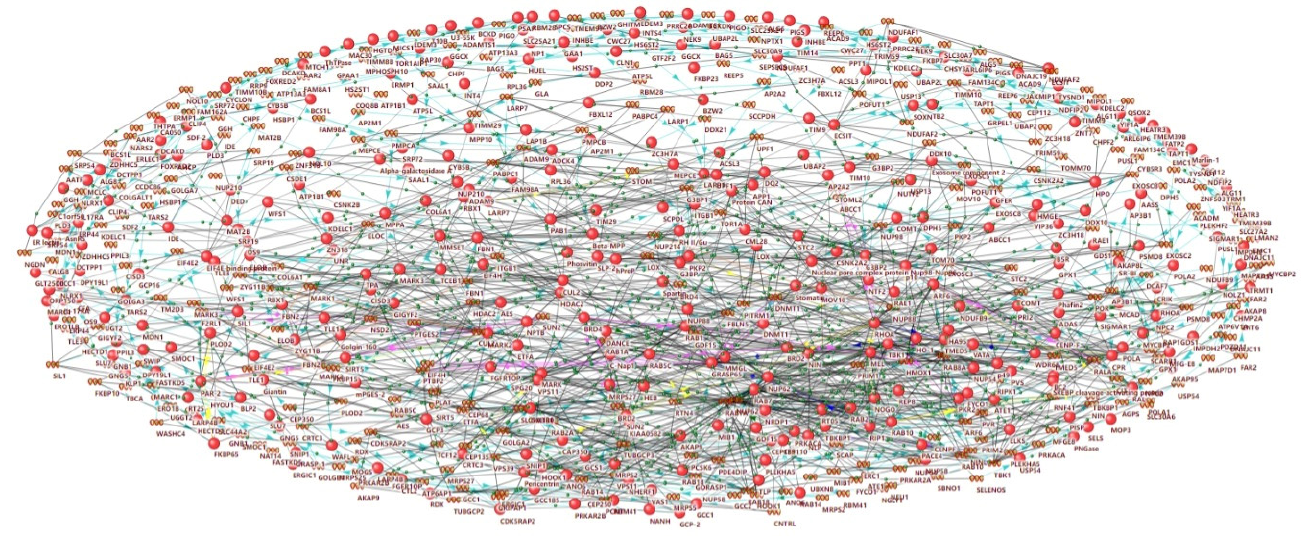
Figure 9. Gene network of human proteins targeted by SARS-CoV-2. Most of the nodes in the network (203 of 332) turned out to be proteins with binding activity. The network included the molecules that bind RNAs, macromolecular complexes, chaperones, enzymes, microtubules, guanosine triphosphate (GTP), and other molecules. There were some proteins with ATPase and GTPase activity, oxidoreductases, metalloendopeptidases, kinases, nucleoporins, and fibrillins (Figure 10).